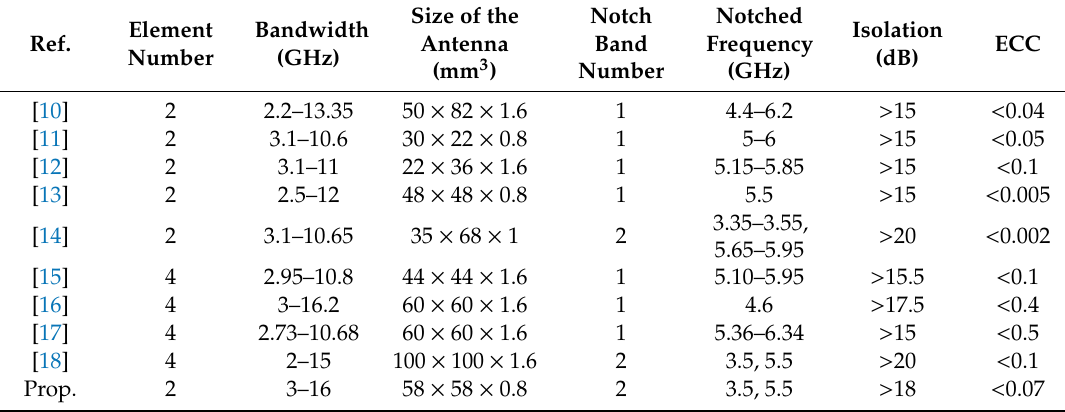
Table 2. Comparison among the presented MIMO antenna and the previously reported band-notched UWB MIMO